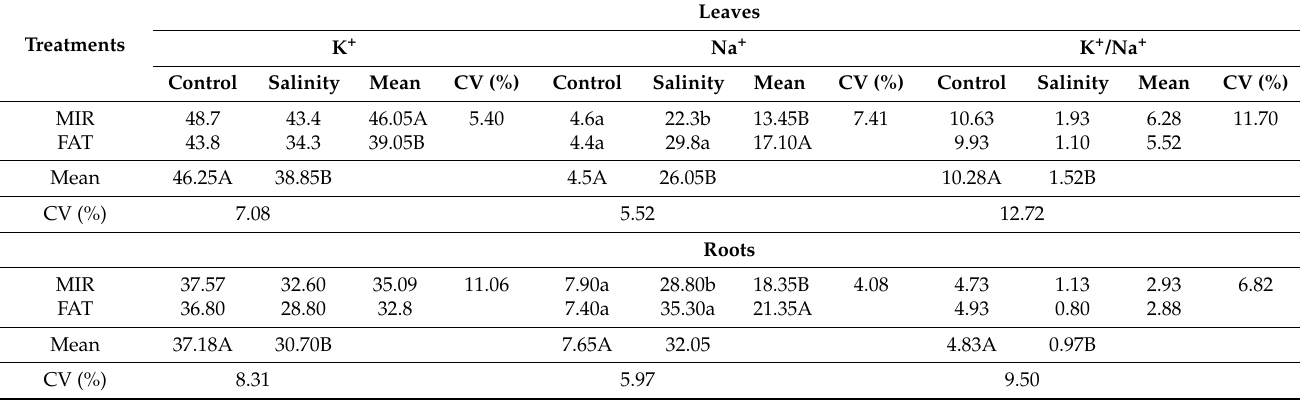
Table A2. K, Na, and K/Na concentration in leaves and roots of both wheat varieties under both control and salt stress